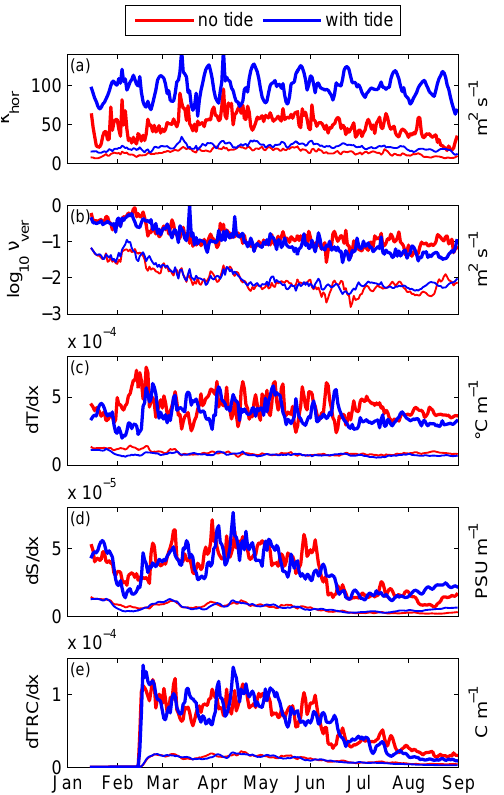
Fig. 8. Time series of averages calculated within a 50m thick bot- tom layer over an area around the Sørkapp headland (hatched box in Fig. 6a) for the non-tidal (red) and tidal run (blue) of the HIGH scenario ( S sill = 35 . 8, with wind). (a) Horizontal diffusivity coef- ficient, (b) vertical viscosity coefficient, (c) horizontal temperature gradient, (d) horizontal salinity gradient, (e) horizontal gradient of passive tracer concentration. Bold lines are maximum values, thin lines are averages.